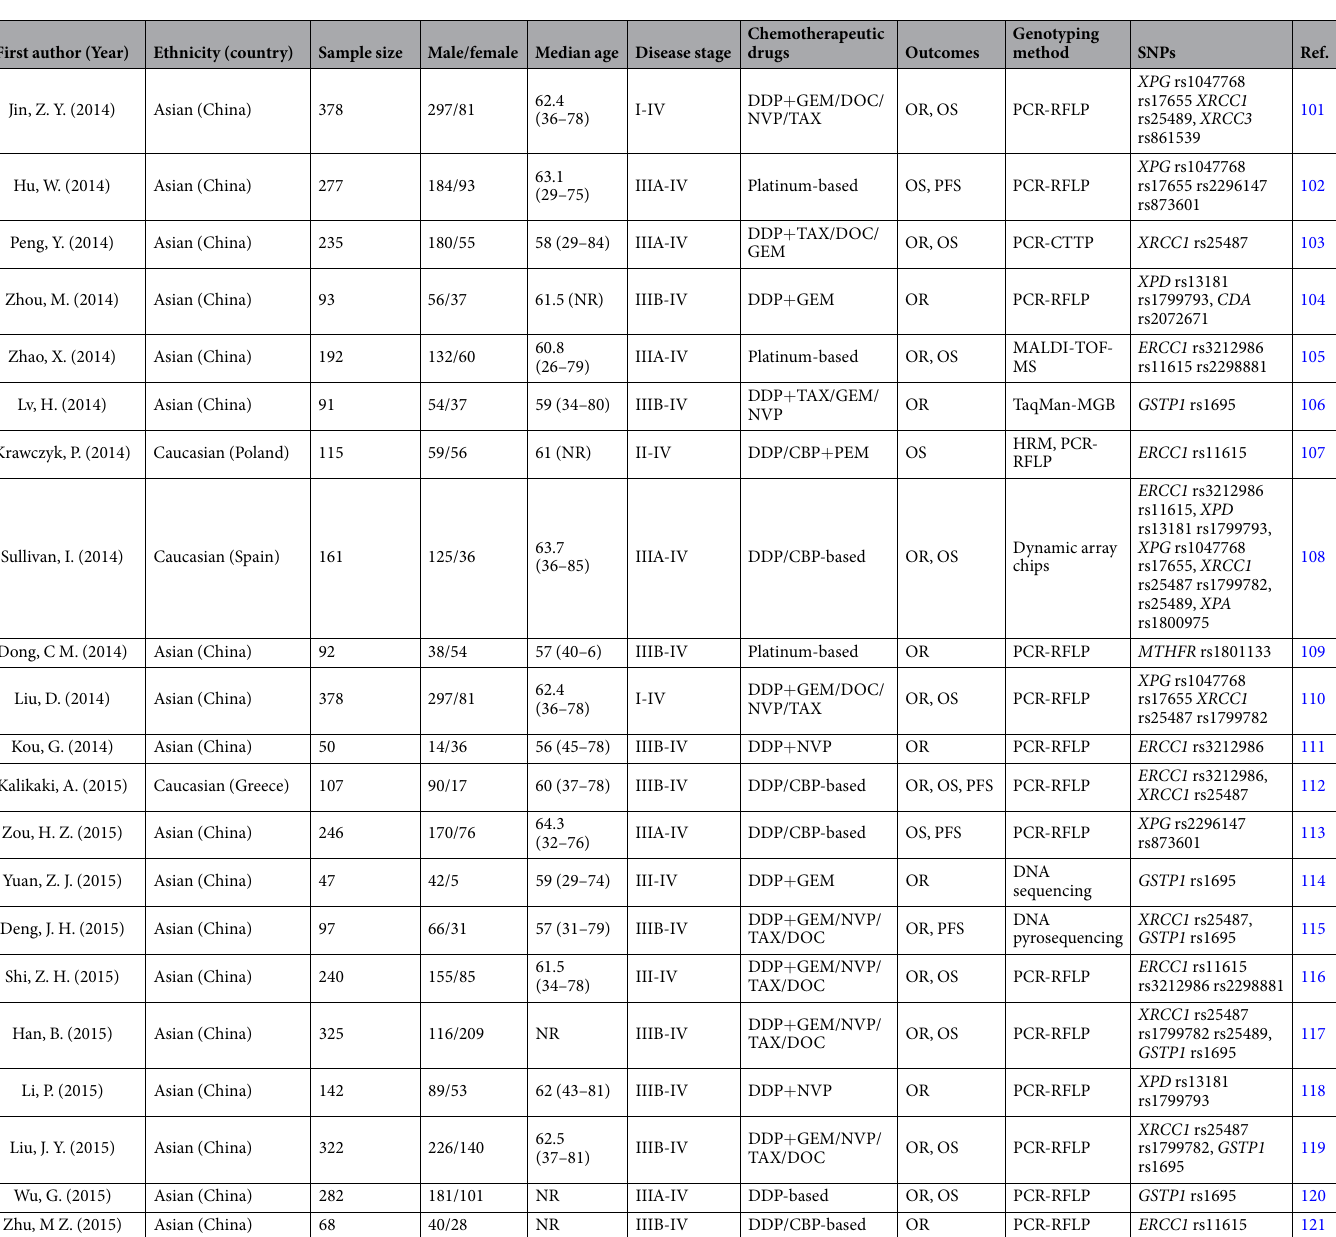
Table 1. The baseline characteristics of the studies included in this meta-analysis. NR, no report; DDP, cisplatin; CBP, carboplatin; GEM, gemcitabine; NVP, vinorelbine; PEM, pemetrexed; TAX, taxol/paclitaxel; DOC, docetaxel; LDR, Ligase detection reactions; PCR-RFLP, polymerase chain reaction-restriction fragment length polymorphism; SBE, single base extension; HRM, High Resolution Melt; MALDI-TOF-MS, matrix- assisted laser desorption/ionization time-of flight mass.